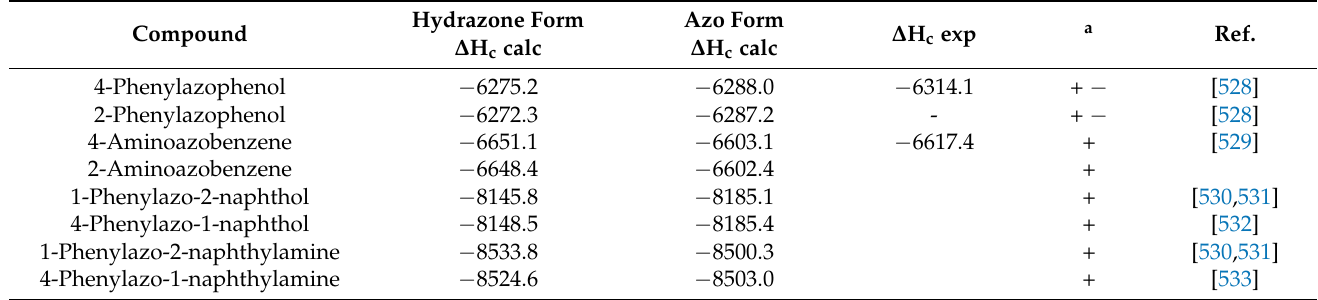
Table 6. Calculated ∆ H ◦ (c) (in kJ/mol) of Azo and Hydrazone Forms of some Azo Dyes. Compound